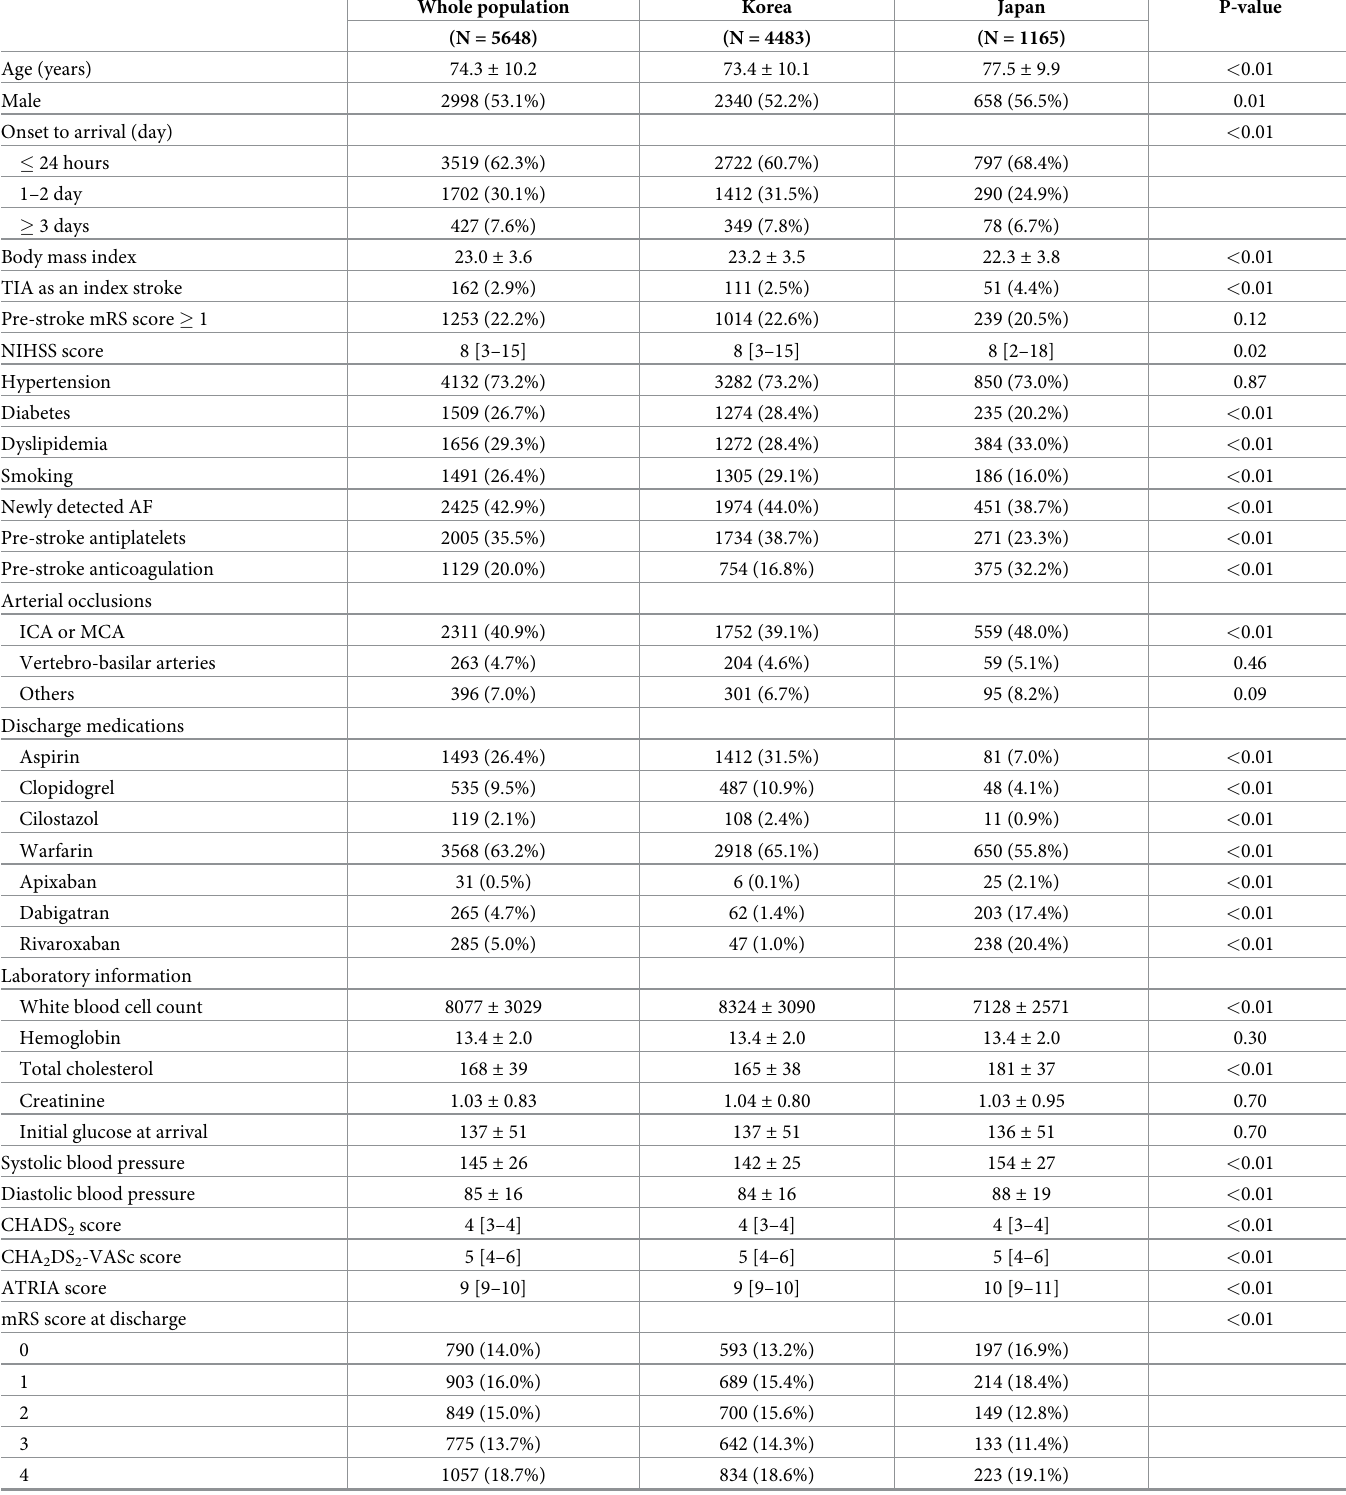
Table 1. Clinical profile of the developmental dataset, stratified by the recruiting